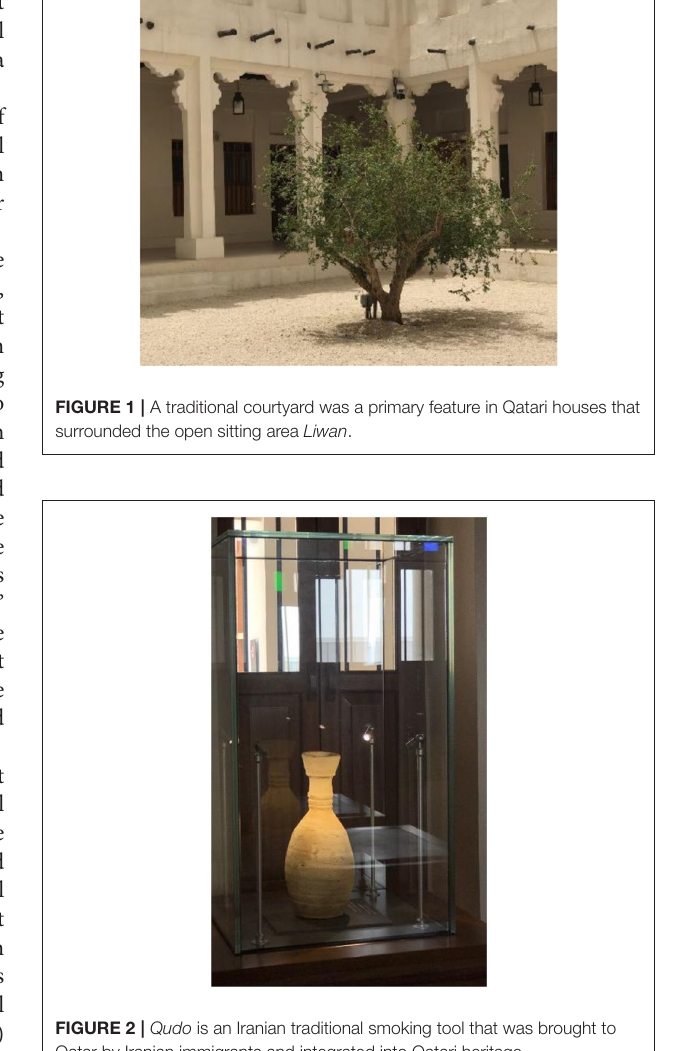
Excavations revealed ancient lighting equipment and